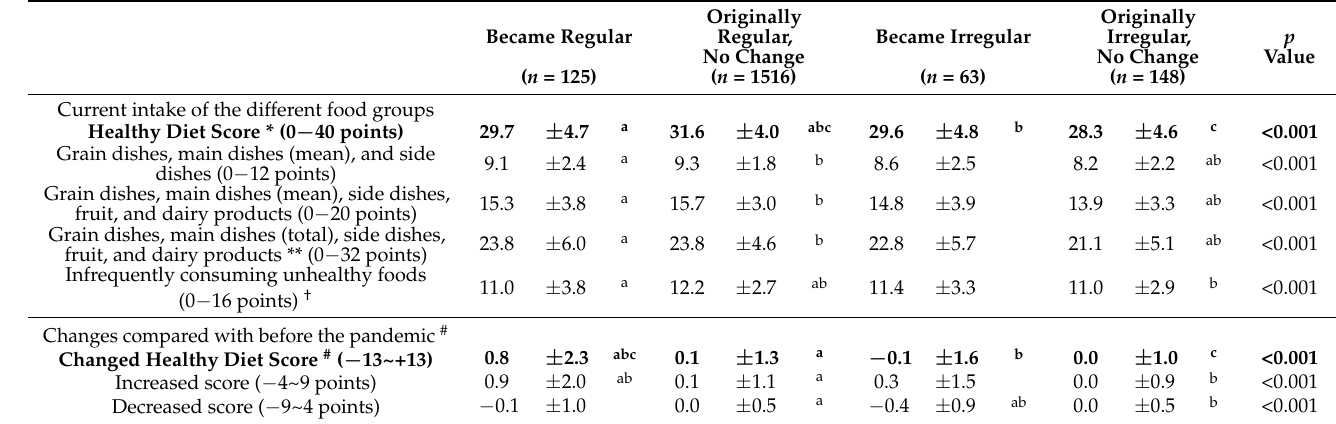
The continuous variables presented in the table are expressed as mean ± standard deviation. One-way analysis of variance (multiple comparisons using the Games–Howell method; a–c , performed for significant differences). HDS, healthy diet score; C-HDS, changed healthy diet score. * The intake frequency of each food group was determined and used to calculate the total intake frequency of grain dishes; main dishes (mean); side dishes; fruit;